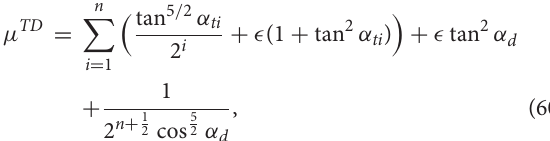
FIGURE 11 | T-bar